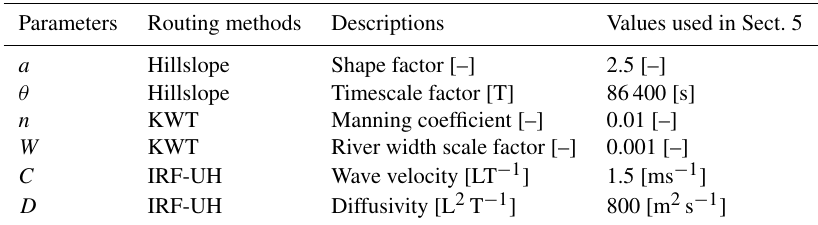
Table 1. Routing model parameters.